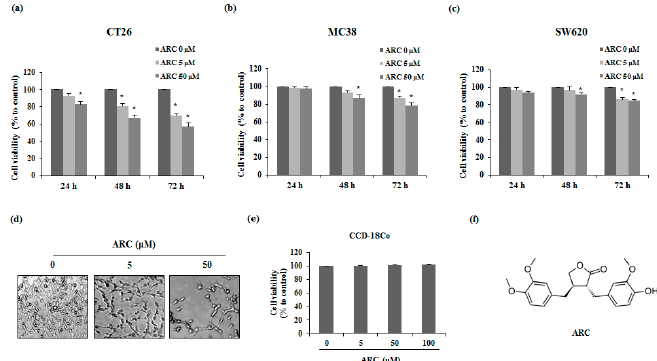
Figure 1. ARC decreases cell proliferation of metastatic colon cancer cells. ( a – c ) Cell viability of ARC-treated CT26 ( a ), MC38 ( b ), and SW620 ( c ) cells; ( d ) the morphology of ARC-treated CT26 cells